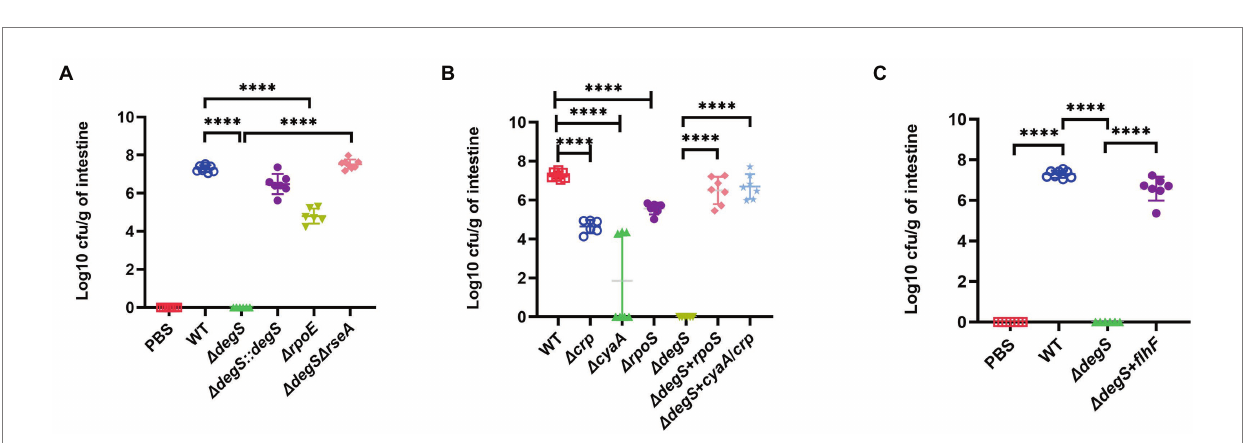
FIGURE 5 DegS influences Vibrio cholerae intestinal colonization via the cAMP–CRP–RpoS–FlhF pathway. (A–C) The numbers of bacteria in the intestine of suckling mice after infection with 1 × 10 7 colony-forming units of the WT, Δ degS , Δ degS::degS , Δ rpoE , Δ degS Δ rseA , Δ cyaA , Δ crp , Δ rpoS , Δ degS + rpoS , Δ degs + cyaA / crp , and Δ degS + flhF strains for 18 h. The results are expressed as the logarithm of colony-forming units/g intestine (cfu/g; ±SD, n = 8). ****, p < 0.0001 between two strains (unpaired t